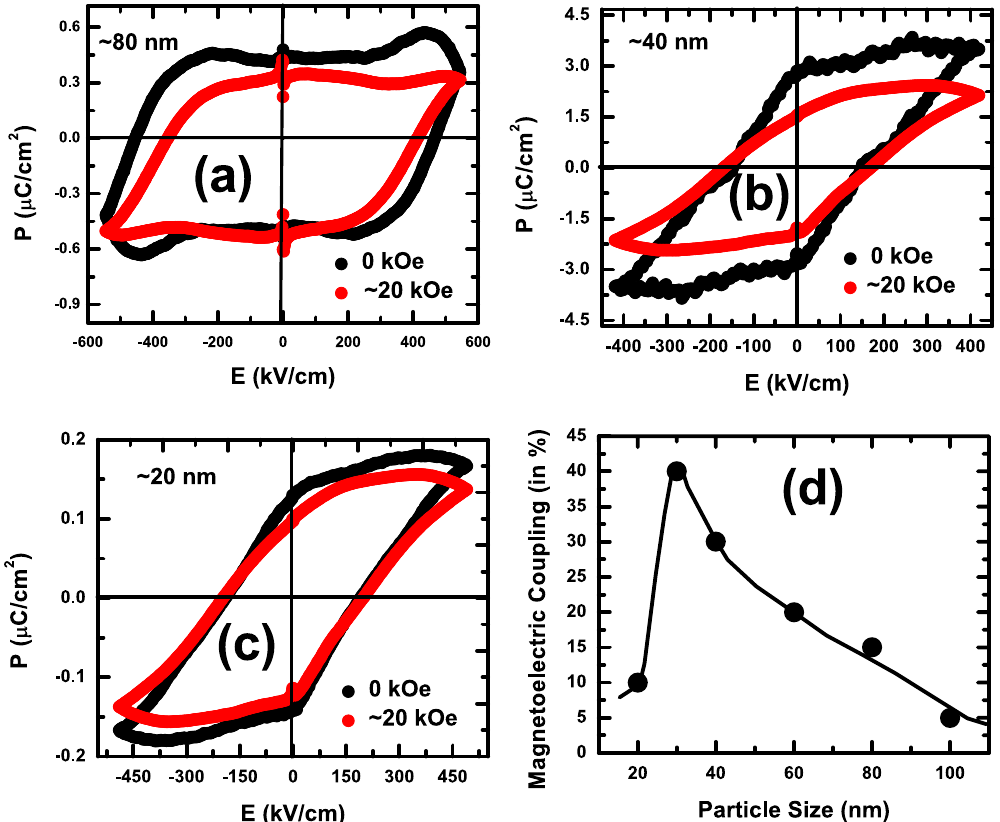
Figure 6. The remanent ferroelectric hysteresis loops measured at room temperature under zero and ∼ 20 kOe field for samples containing particles of sizes ( a ) ∼ 80 nm, ( b ) ∼ 40 nm, and ( c ) ∼ 20 nm; ( d ) the overall pattern of variation of magnetoelectric coupling (in %) with particle size obtained from this direct electrical measurements on the